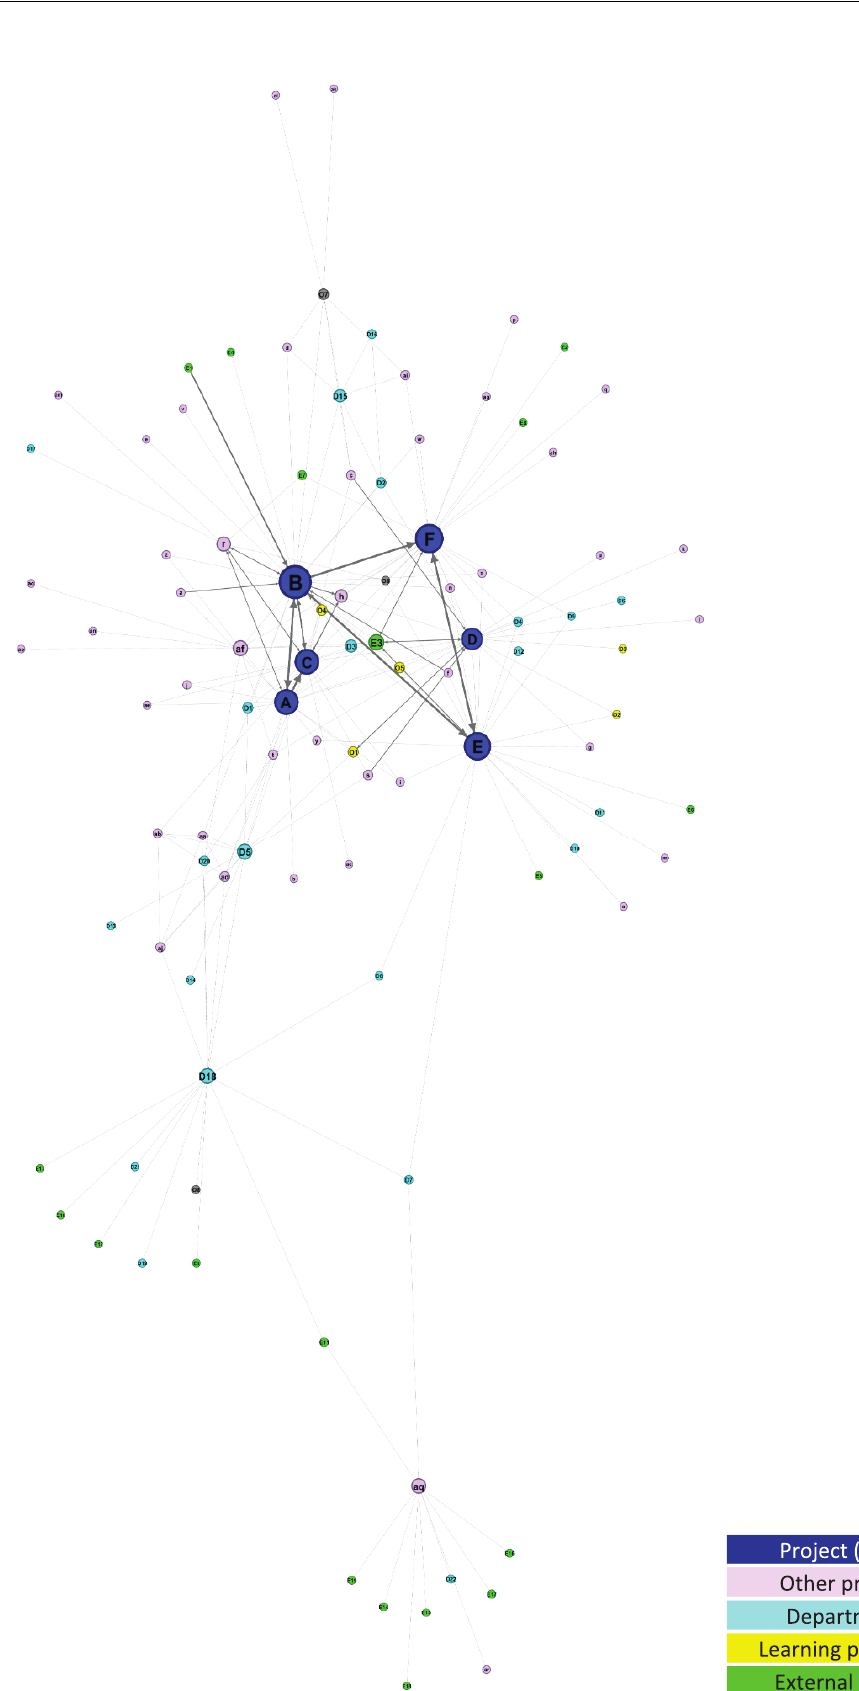
Figure 2. Network visualisation of interactions in the case